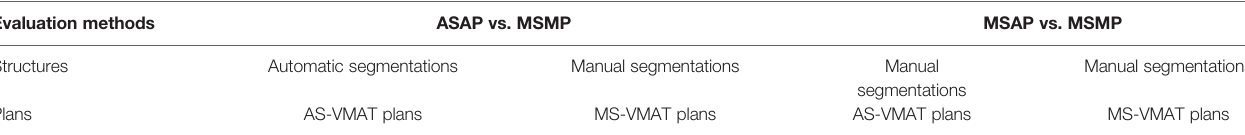
TABLE 1 | Speci fi c compared items in the evaluation of dose differences to organs at risk (two evaluation